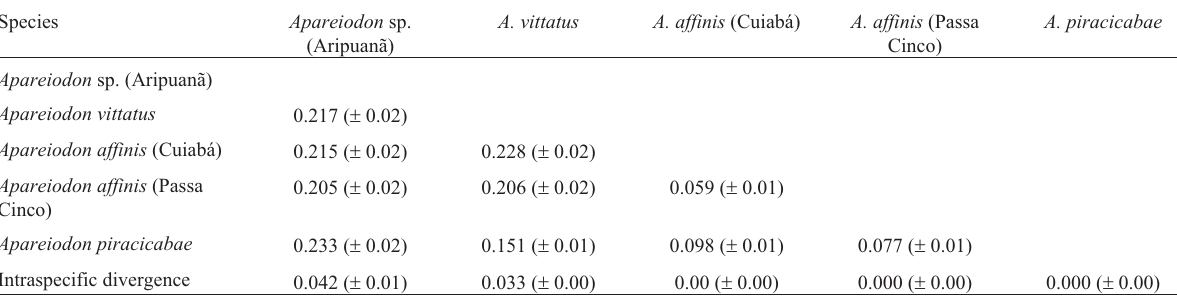
cluded were 1st+2nd+3rd. All positions containing gaps and missing data were eliminated. There was a total of 441 positions in the final dataset.